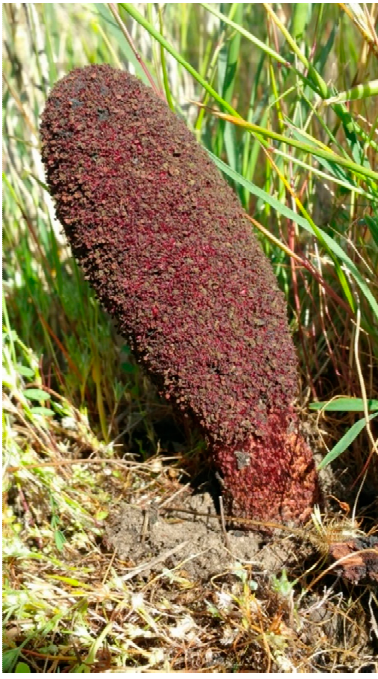
Figure 1. A picture of the aerial part of Cynomorium coccineum growing close to a salt marsh (Sardinia, Italy).